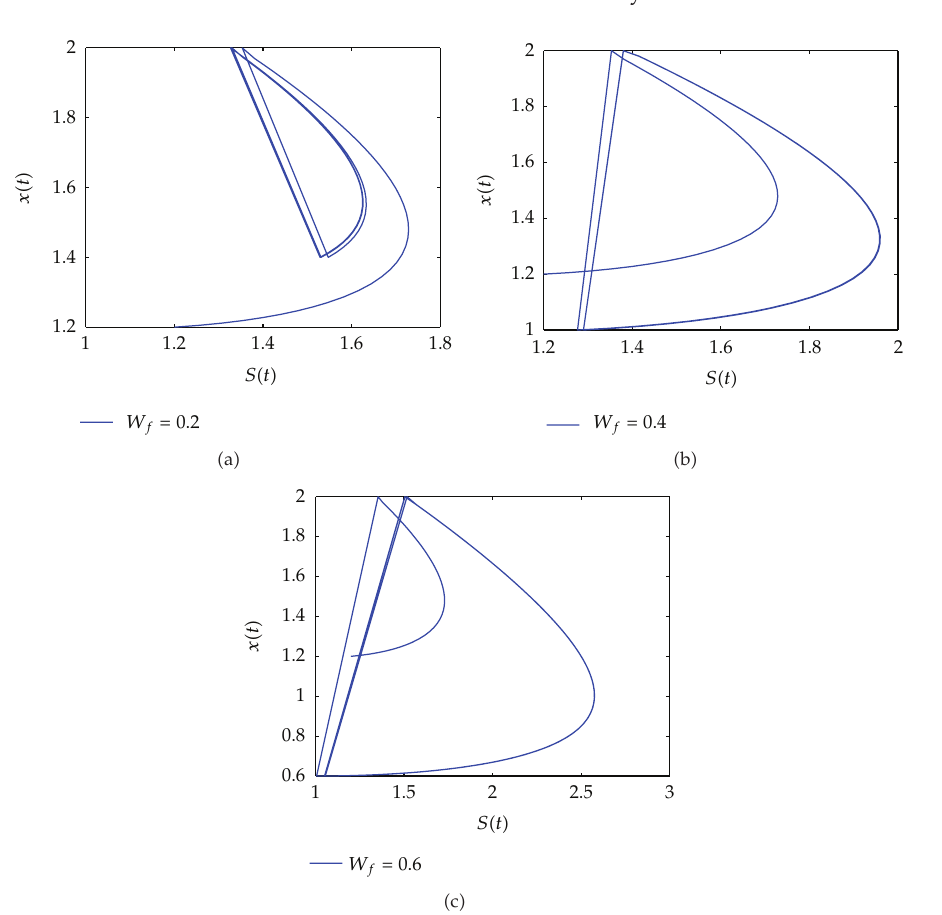
Figure 9: The phase diagram for system (cid:5) 2.6 (cid:6) starting from initial point (cid:5) S 0 ,x 0 (cid:6) (cid:7) (cid:5) 1 . 2 , 1 . 2 (cid:6) with a (cid:7) 2, (cid:7) 0 . 2 , 0 . 4 , 0 . b (cid:7) 1 . 5, x set (cid:7) 2 (cid:3) g/l (cid:4) , and W f 2